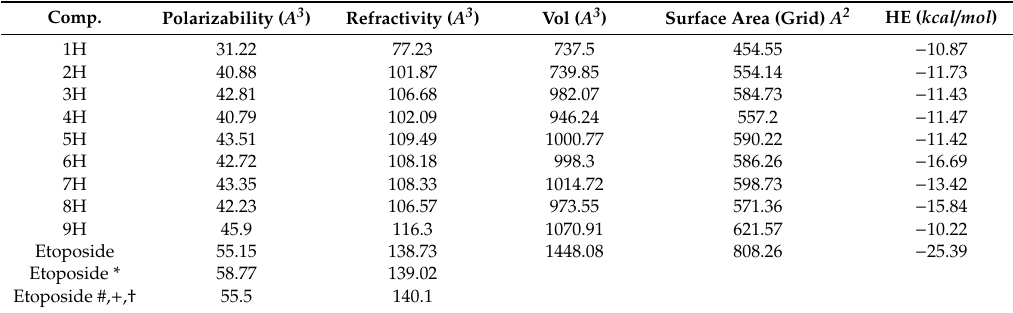
Table 9. QSAR properties of the nine derivatives of TUDIHPP (1H-9H).